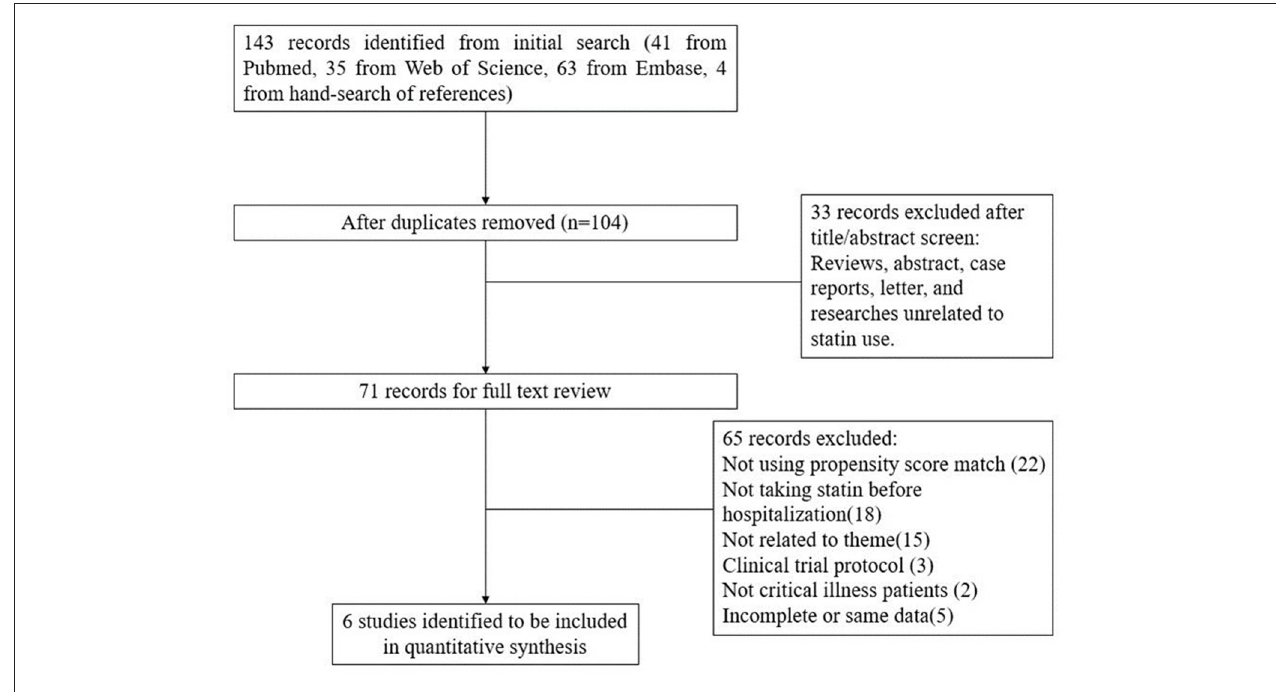
FIGURE 1 | Flowchart for selection